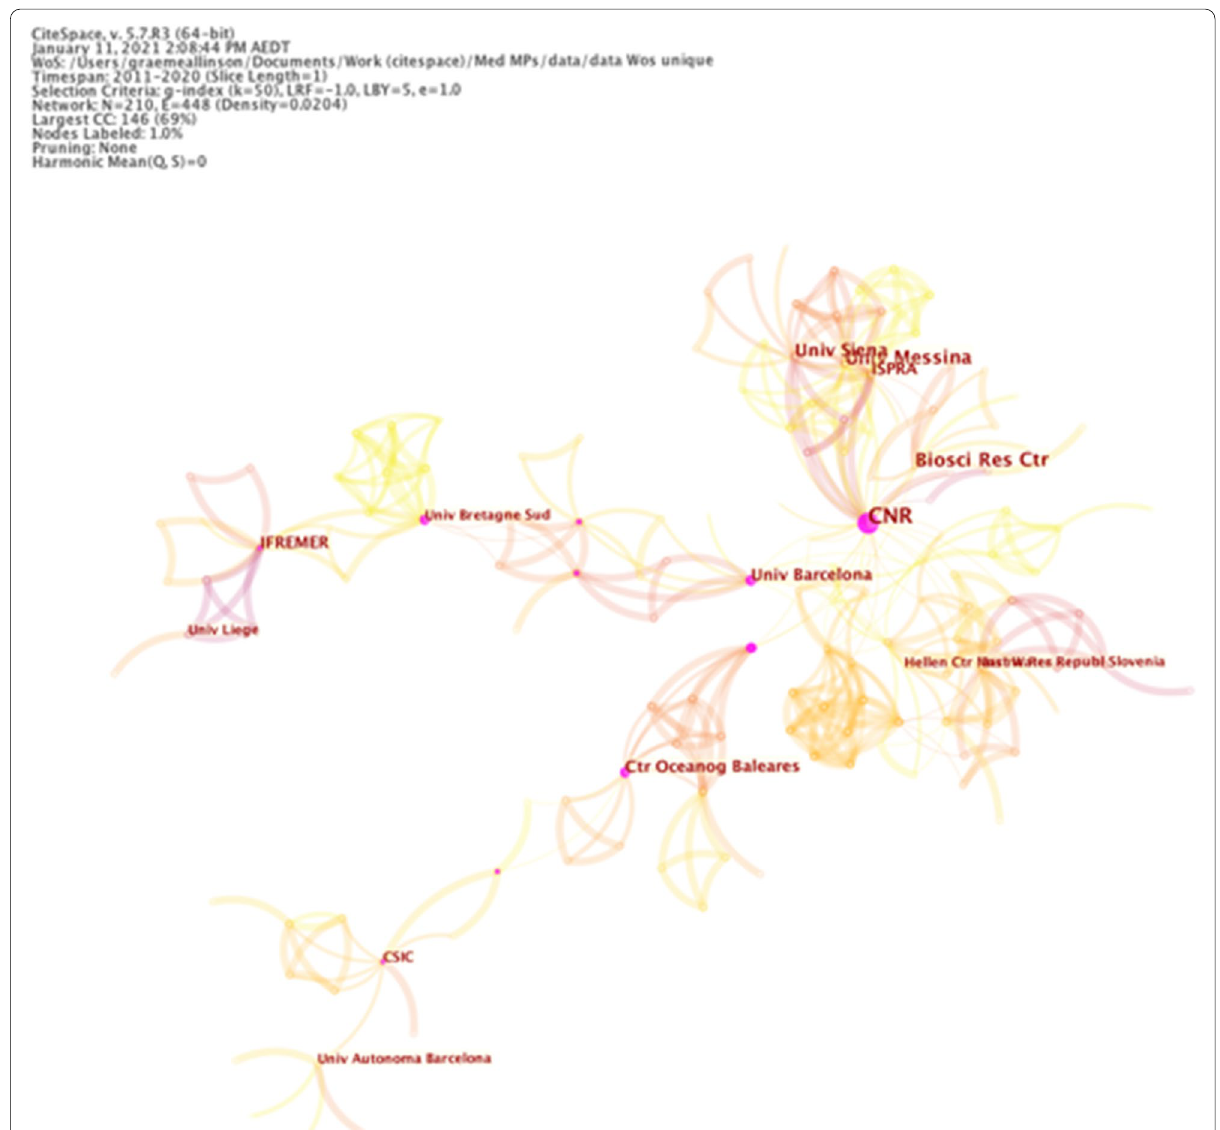
Fig. 3 Distribution of organisations based on number of records attributed to authors based in each organisation (modularity Q silhouette 0.9401). Node size signifies the number of papers that originated from the country. Distance between nodes and link thickness = indicates the level of collaboration, link colour indicates earliest period of establishment (purple, oldest; yellow, most recent). Nodes without labels were below the threshold ( n =